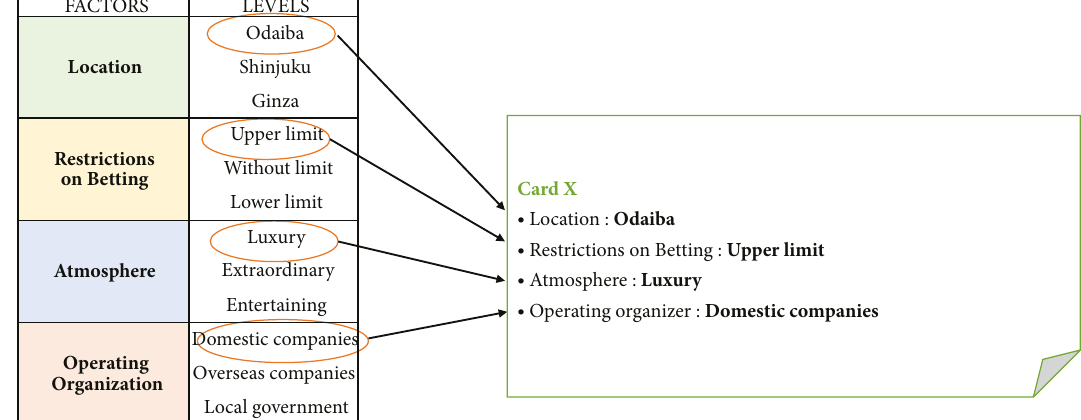
Figure 5: Preference for each factor based on the highest preference scores (Card X).